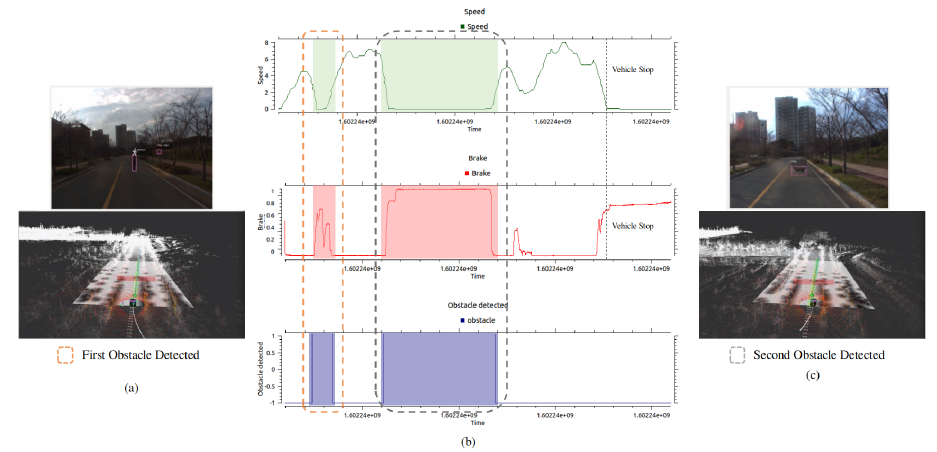
Figure 14. The quantitative evaluation of obstacle detection using the proposed autonomous vehicle is illustrated. ( a , c ) show the obstacle detection in camera and Lidar frame using YOLOv3 and PointPillar network respectively. ( b ) The latency of speed, brake and obstacle profile is illustrated. It is shown in the graph that when the obstacle is detected, the vehicle speed slows down and brake command is promptly activated. The synchronization between the three profile is clearly seen with total execution time of 1650 µ s. In ( b ) at the detection of second obstacle, the graph profile of speed, brake and obstacle remain in their respective state, this corresponds that the obstacle is present in the route of autonomous vehicle and have not changed the place for that much period. The speed is in (m/s), brake command is command to vehicle CAN bus through drivekit, and obstacle detection is the indication of obstacle